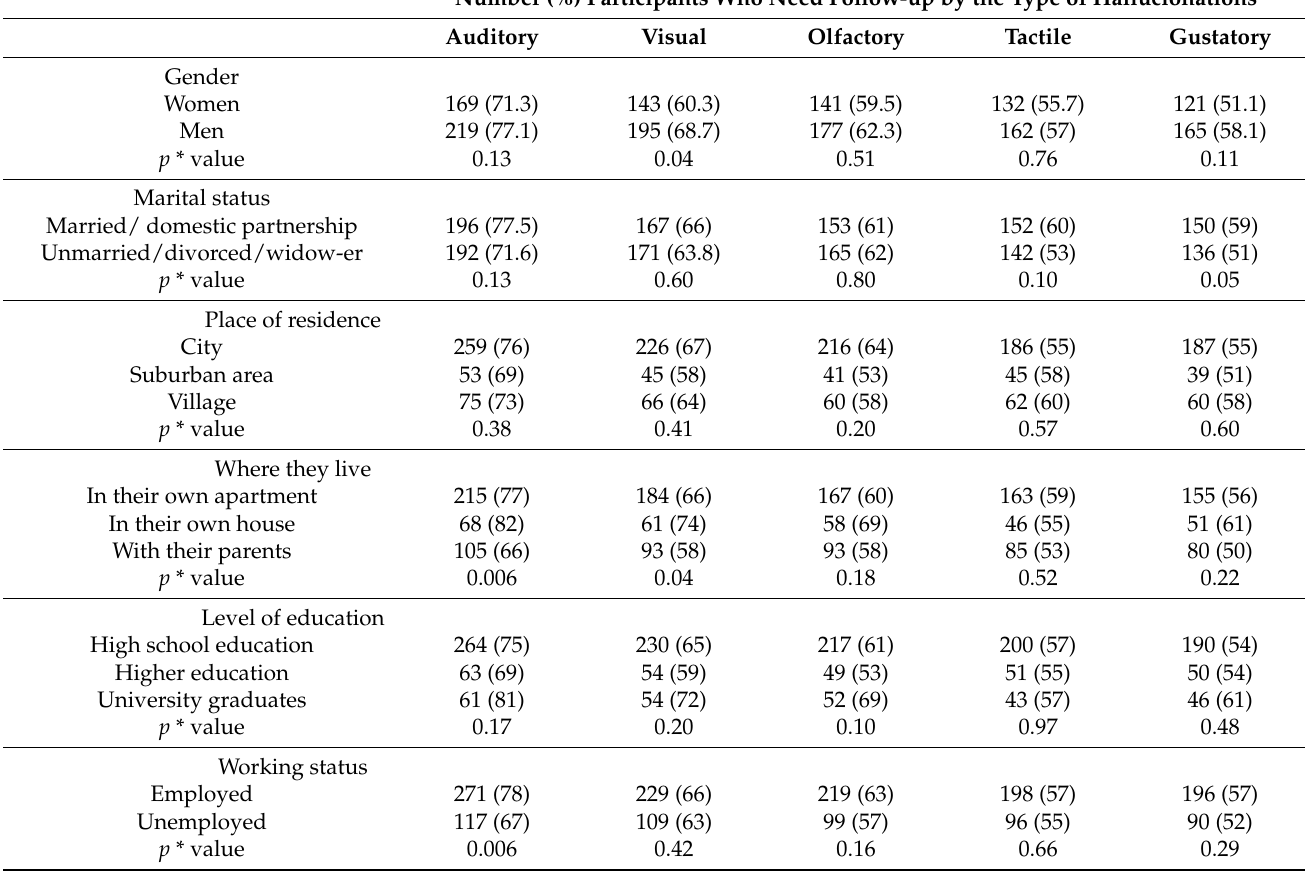
Table 3. Distribution of subjects according to the required control by type of hallucinations in relation to the basic characteristics of the